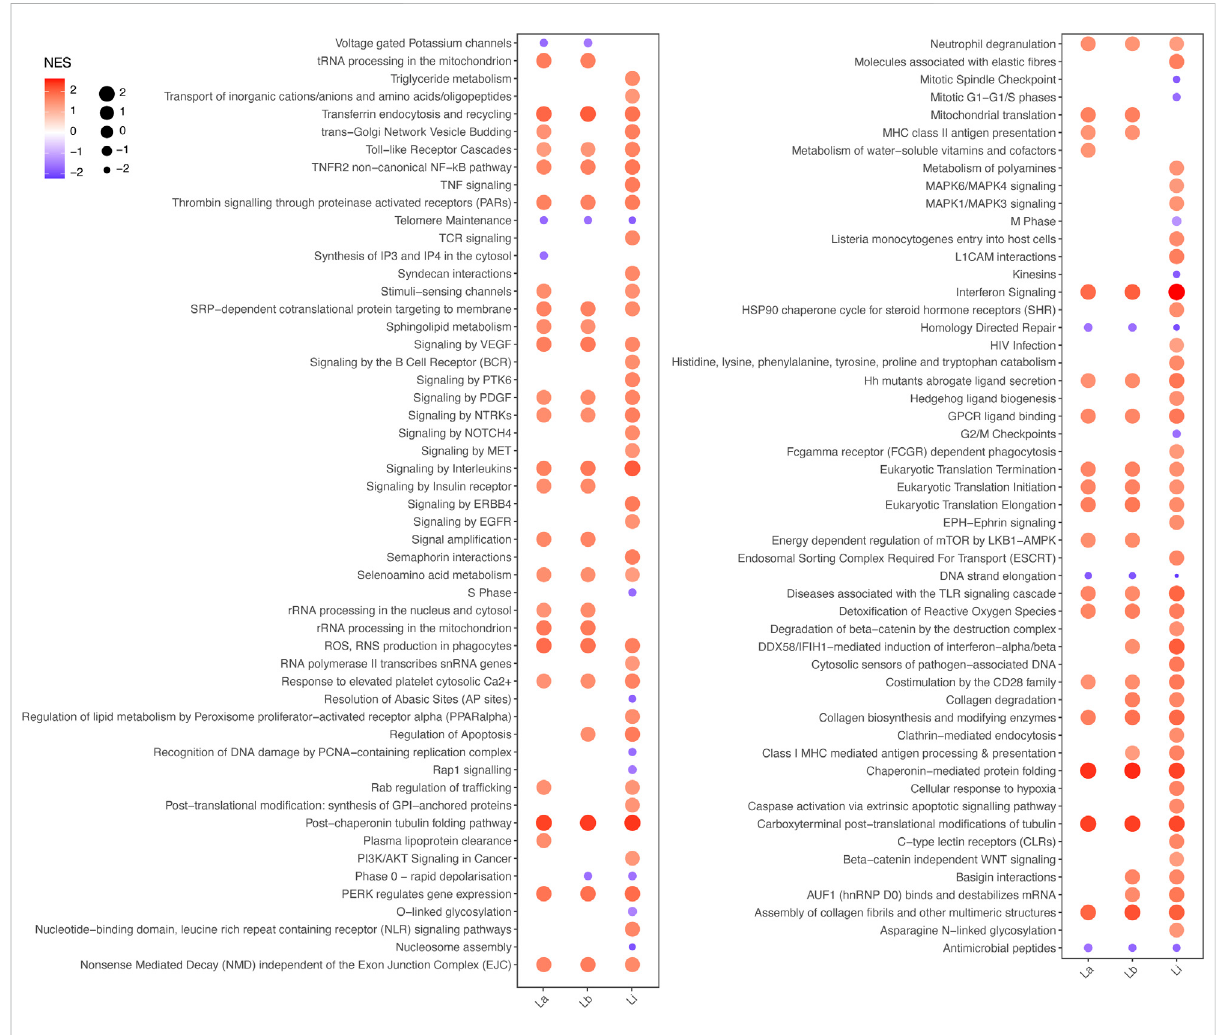
FIGURE 2 Enriched Reactomepathwaysfor La , Lb ,and Li infection inTHP-1 macrophages. Theplotrepresentsthenormalizedenrichmentscore(NES)by both color and bubble size, as indicated in the fi gure legend, of signi fi cantly altered level 3 Reactome pathways based in theprotein coding genes of THP-1 macrophages infected with La , Lb or Li